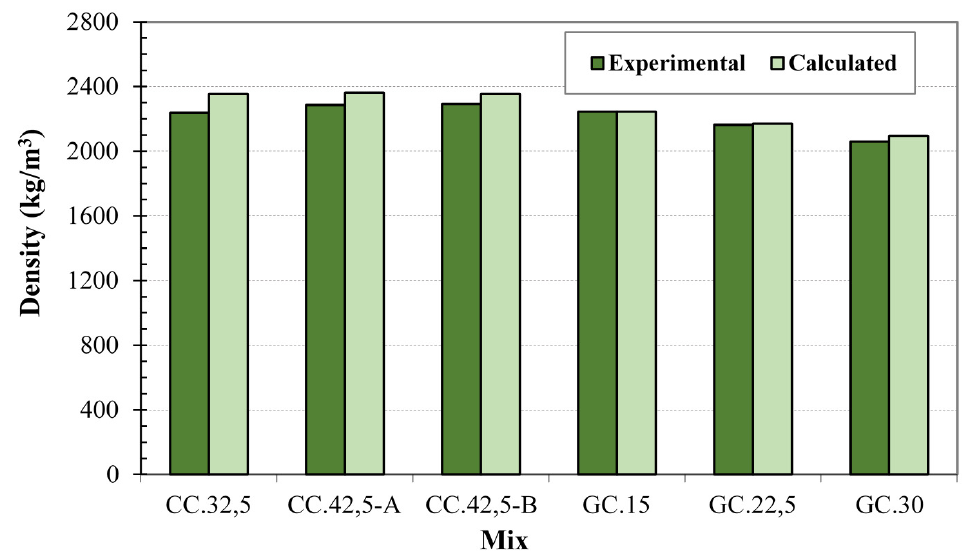
Figure 7. Air content of the mixes.